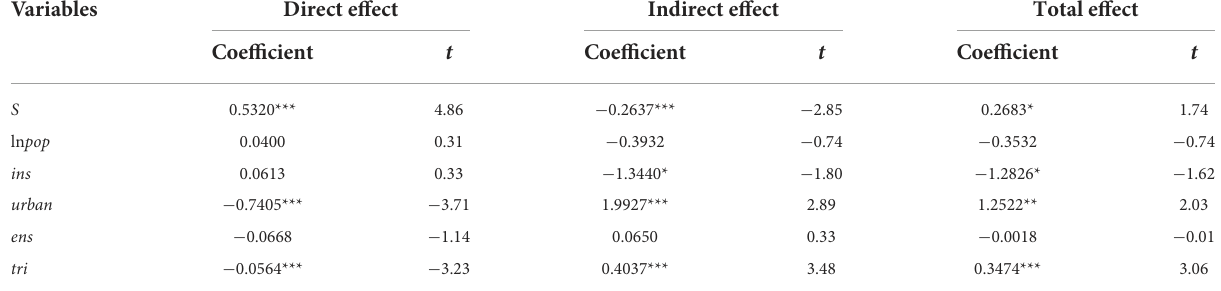
TABLE 10 Robustness test results of control variables